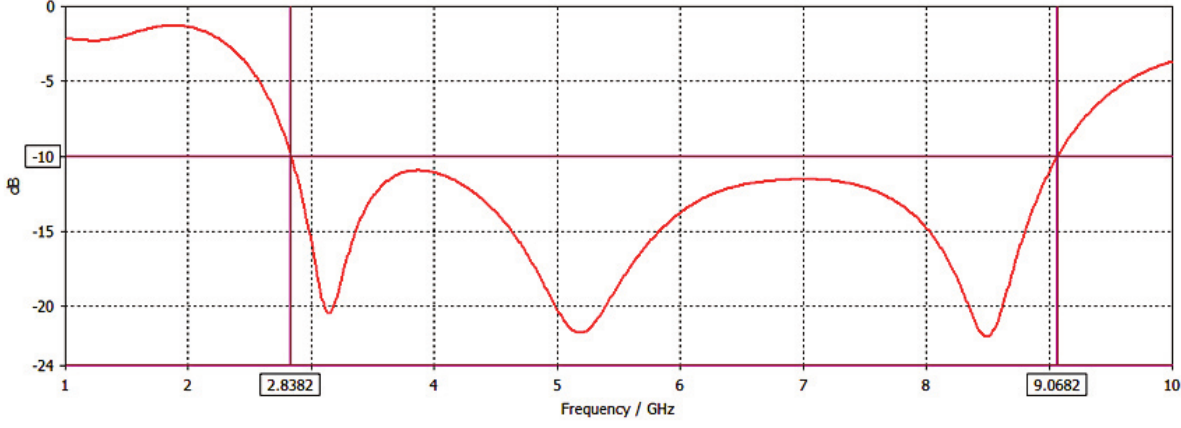
Fig. 5. Input reflection for the simulated antenna.